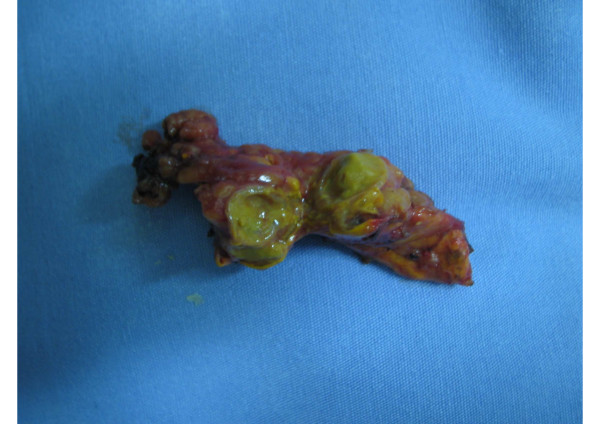
Surgical specimen of the adrenal gland contains an 8 mm cystic mass.